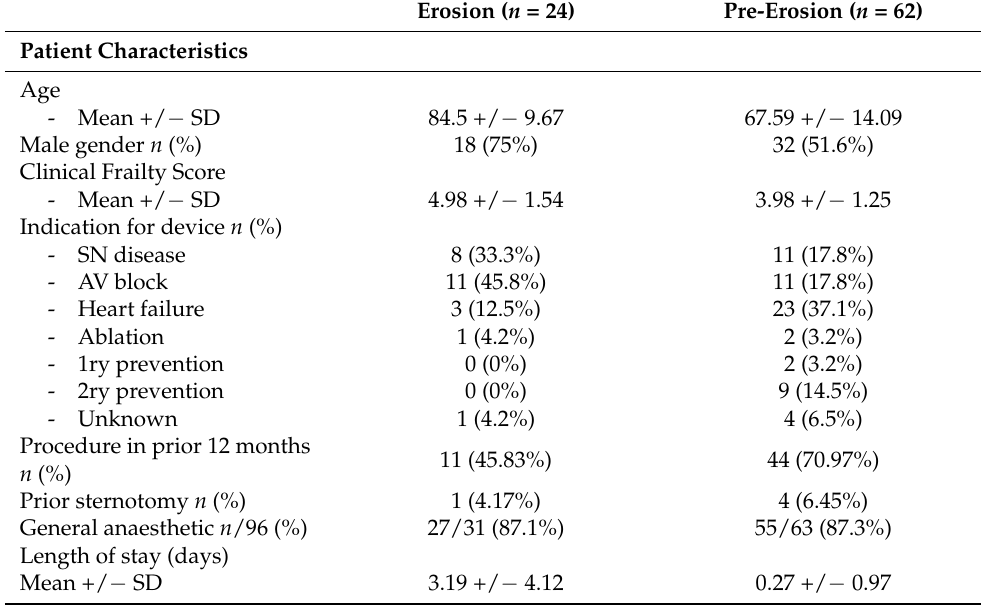
Table 1. Patient and device